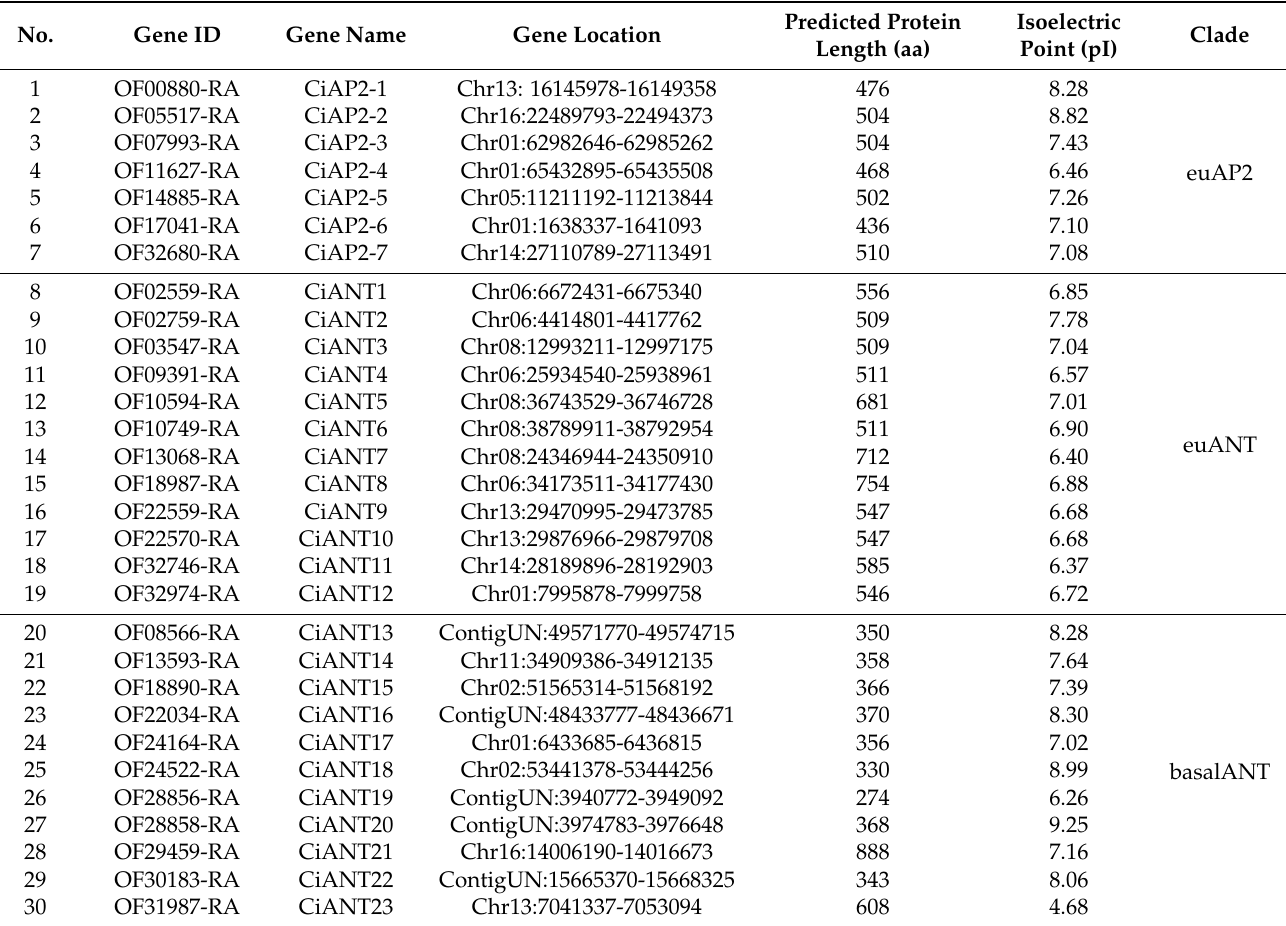
Table 1. AP2 subfamily genes in